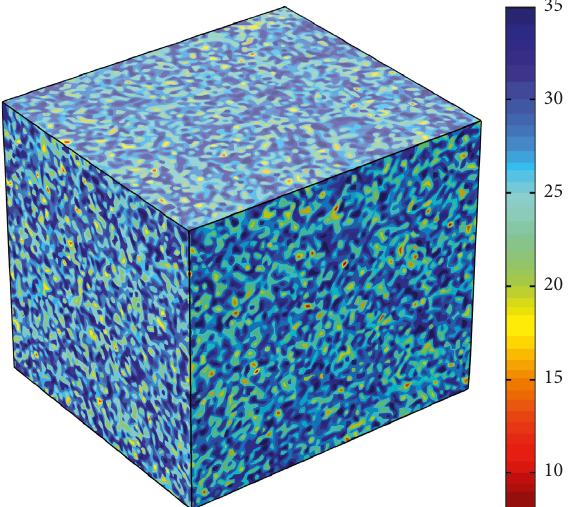
Figure 4: Heterogeneous expression of elastic modulus (unit: GPa).